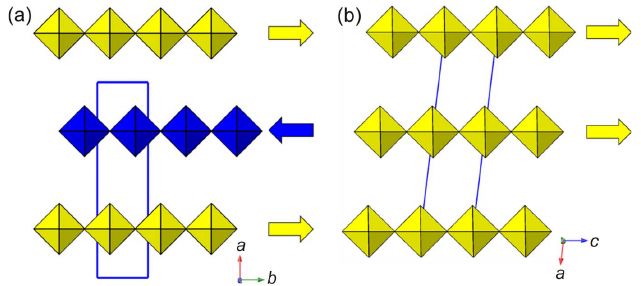
Figure 4 Comparative effects of the two generic types of layer-shift mode acting on the RP parent ( a ) M 5 (cid:2) (a, a) mode (see also Fig. 3) and ( b ) the analogous (cid:3) 5+ mode. Note that the former leads to orthorhombic symmetry, whereas the latter corresponds to a monoclinic distortion.